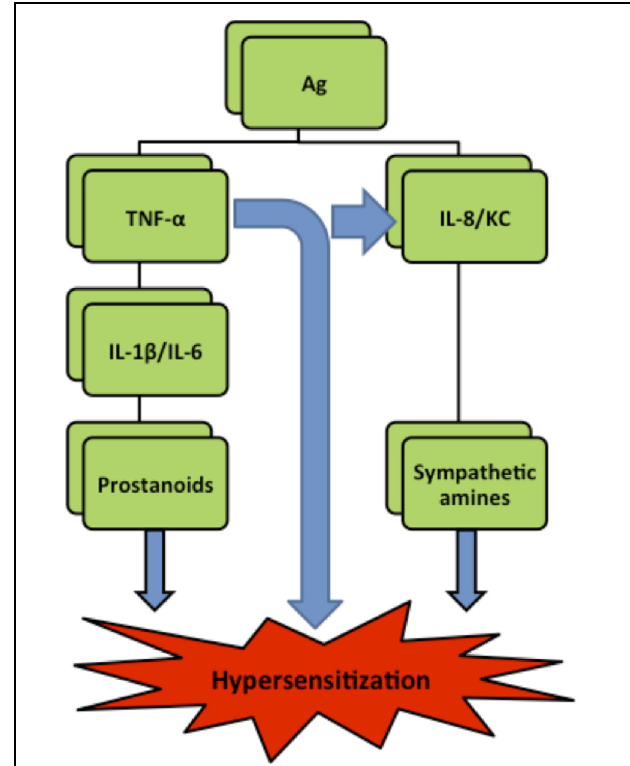
FIGURE 1 | Simplified hyperalgesia pathways in rats. Ag (antigen), IL (interleukin), TNF- α (Tumor necrosis factor- α ), KC (Keratinocyte derived chemokine) (Verri et al.,